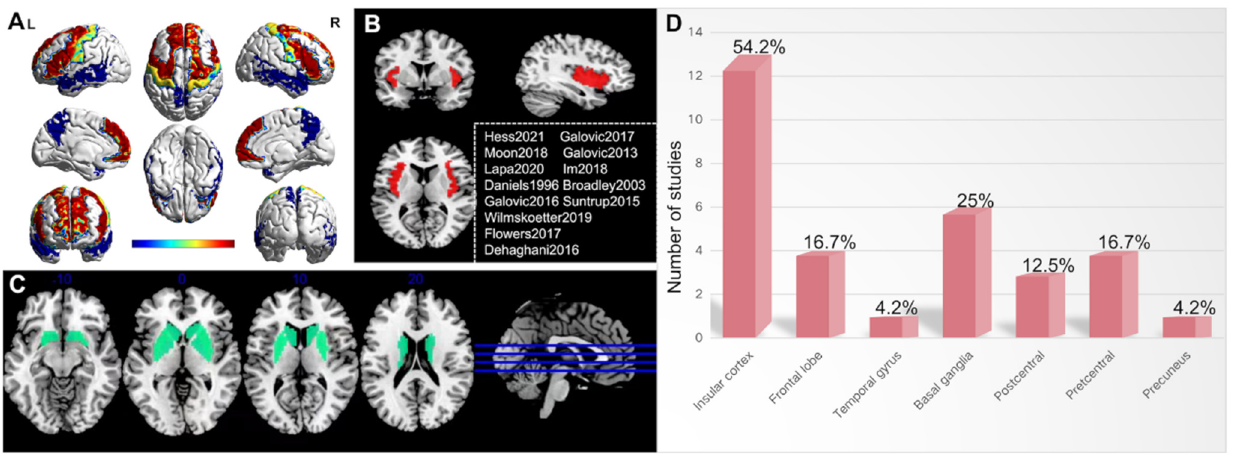
Figure 2. Illustration of lesion overlap and distribution for patients with post-stroke dysphagia (PSD). The insular cortex might be the most relevant brain region for PSD. ( A ) Lobar brain regions related to PSD. ( B ) Insular cortex and corresponding published articles in this review. ( C ) Deep brain regions related to PSD (including basal ganglia). ( D ) The percentages of specific brain regions related to PSD in the included studies. Note: the detailed information (including the lesion reported and the related studies) was shown in Table 2; L, left; R, right.